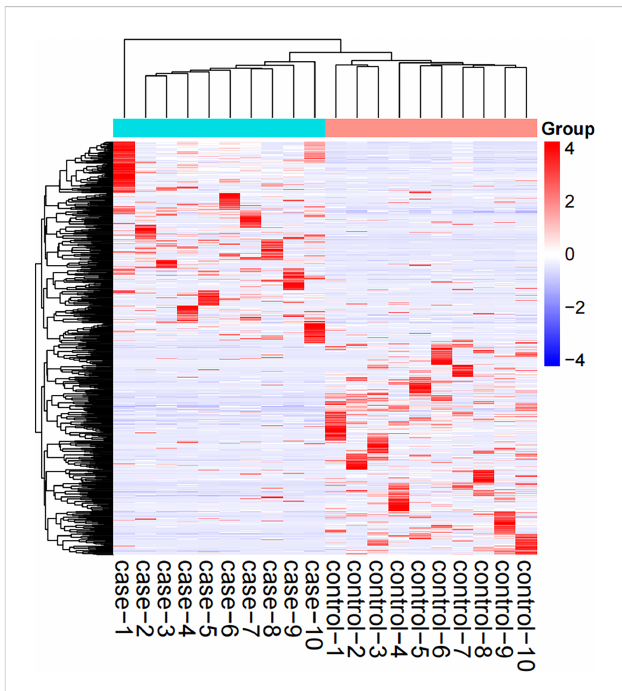
FIGURE 1 Hotspot map of mRNA sequencing results. Case: tuberculosis group;